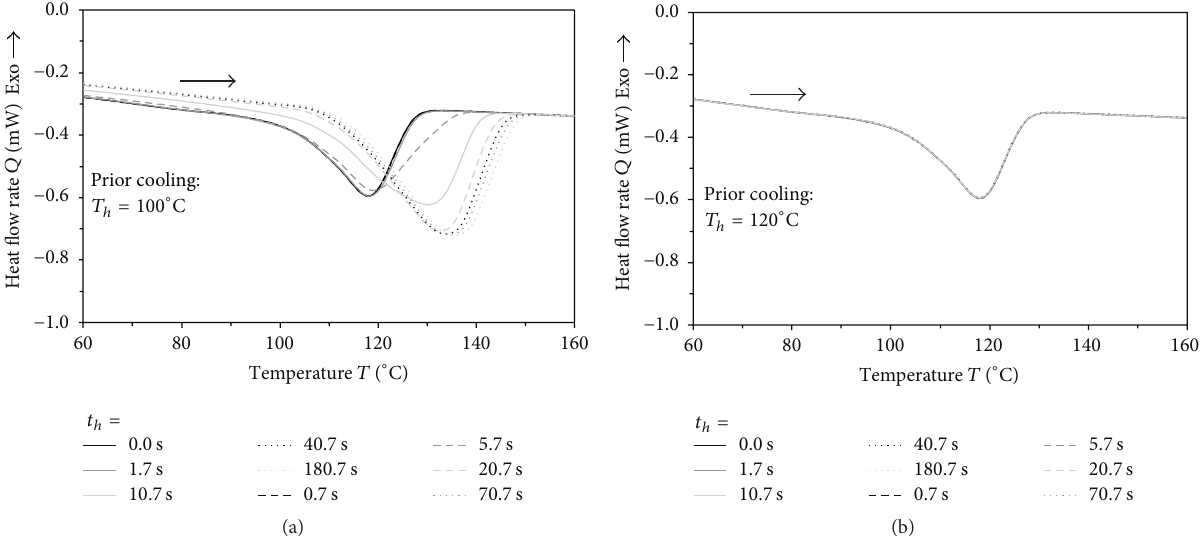
Figure 9: Heat flow rate measured during second heating of process-based cooled samples with isothermal holding step at 100 ∘ C (a) and 120 ∘ C (b).